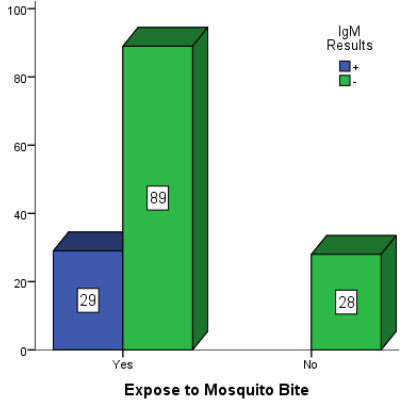
Figure 2. Participants exposed to mosquito bites in Mubi